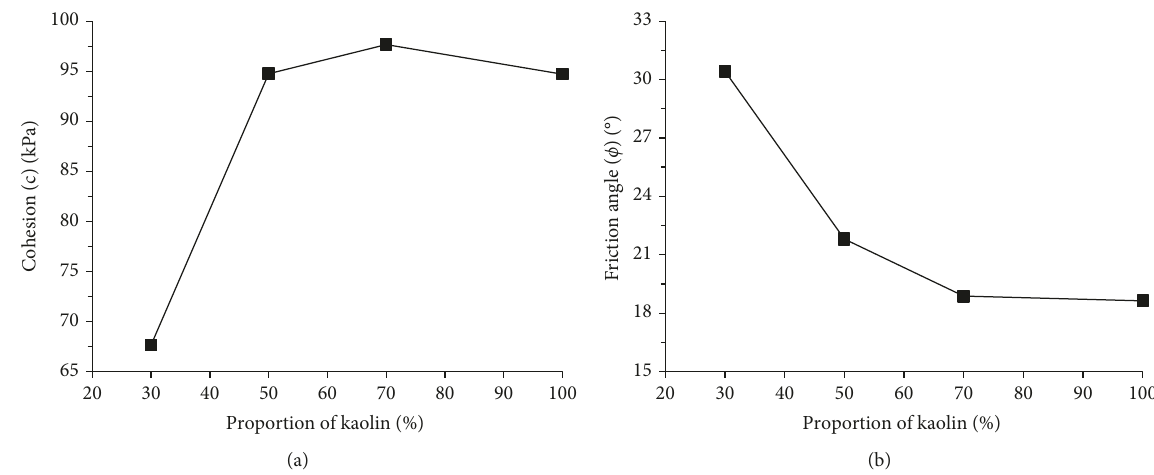
Figure 3: Variation of shear strength properties with clay proportion in the kaolin-quartz mixture: (a) cohesion and (b) frictional angle.